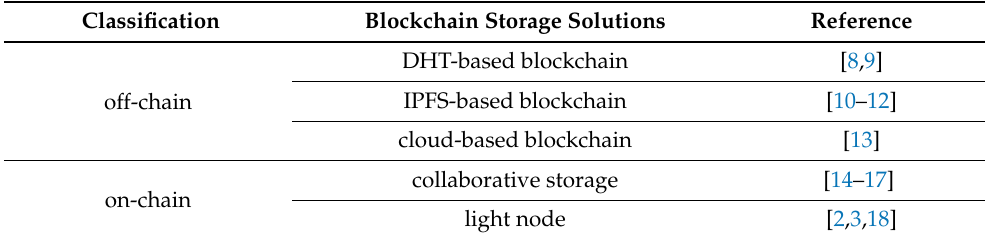
Table 1. Blockchain storage scalability problem